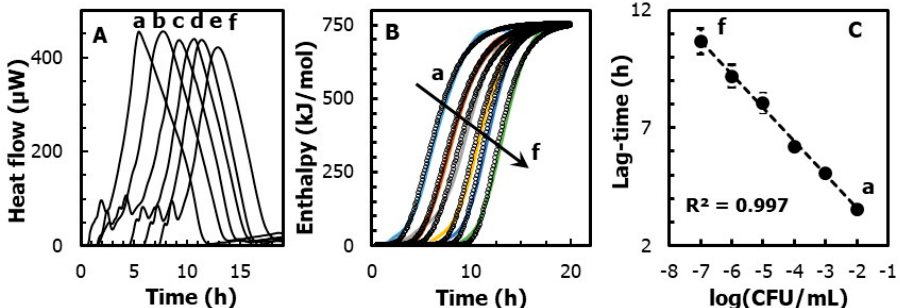
Figure 2. ( A ) Heat-flow traces of E. coli , at a concentration from ( A ) 10 7 to (f) 10 2 log(CFU/mL). ( B ) Heat vs. time curves obtained by integrating the area delimited by the heat-flow profile. Shown also as dotted points is the fitting of the experimental data obtained by the Gompertz function. ( C ) Linear regression of the lag phase, obtained from the Gompertz fitting function, as a function of the E. coli concentration (in CFU/mL).